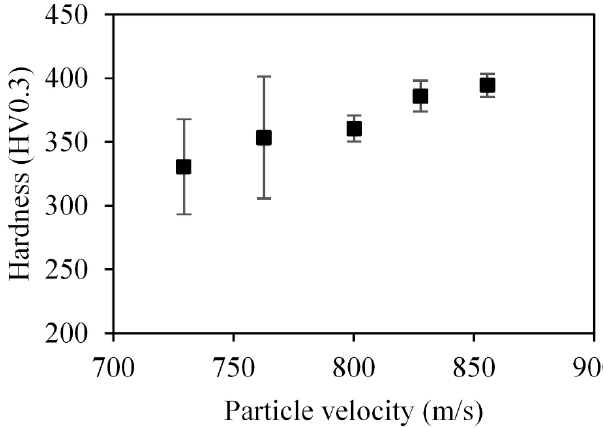
Figure 7. The hardness of coatings’ cross-sections as a function of particle